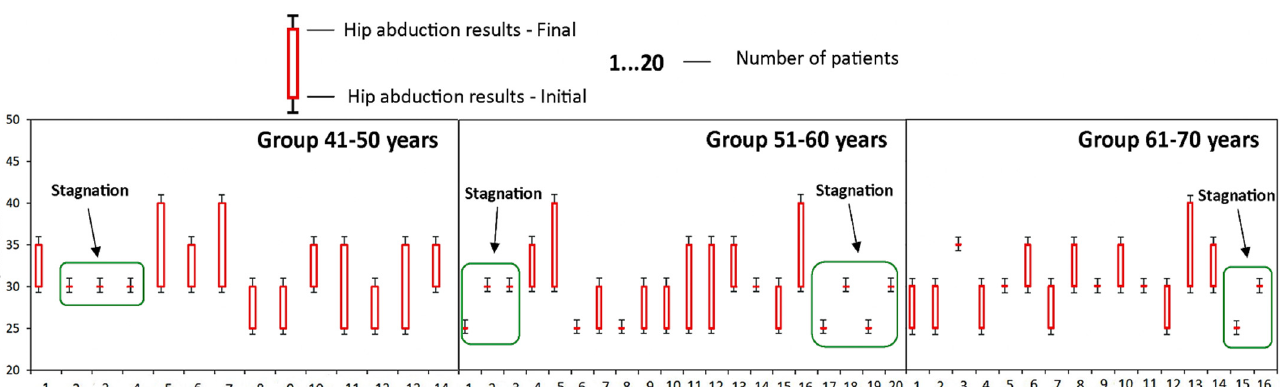
parameter obtained at time T1 is the same as the value of the parameter obtained at time T0; Regress—the parameter obtained at time T1 is less than the value of the parameter obtained at time T0.